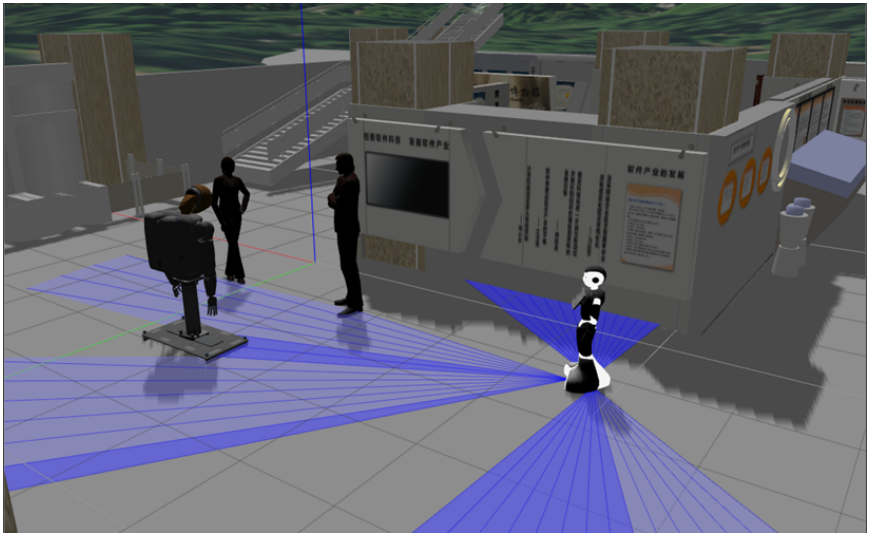
Figure 12. Group of persons with a